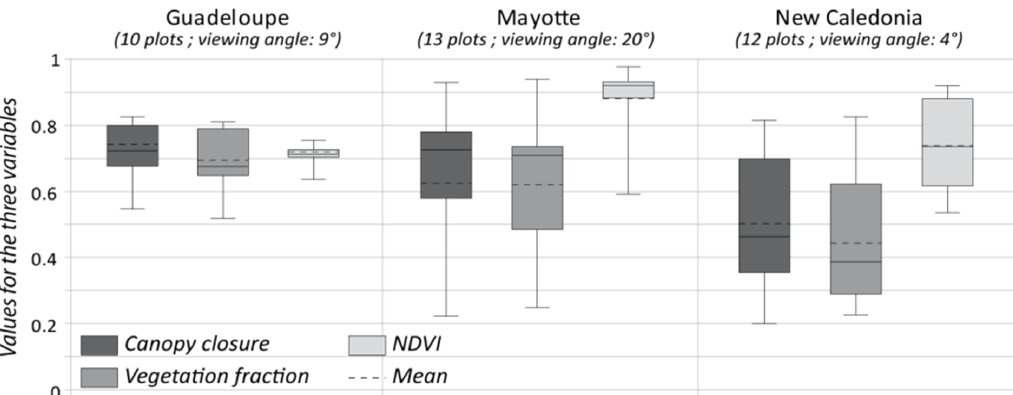
Figure 5. Range of variations of canopy closure, VF and NDVI values obtained from the analysis of Pleiades-1B images acquired over the regional sites. Box plots give the mean, median, quartiles, min and max values.